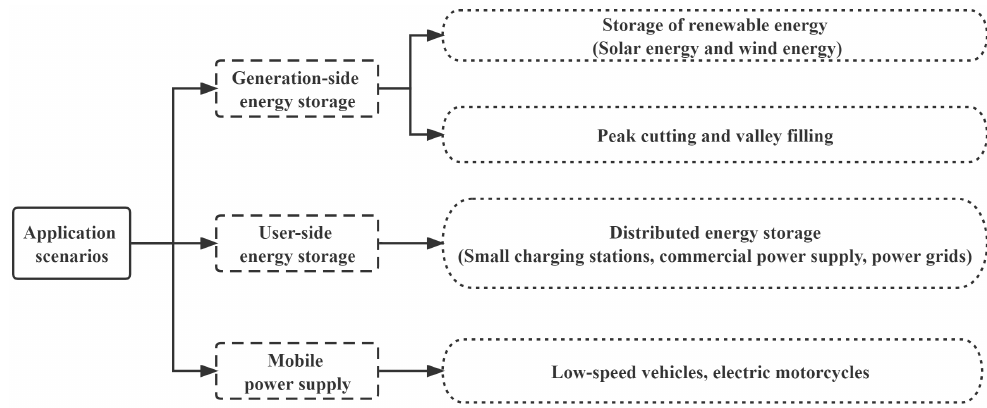
Figure 8. Application scenarios for echelon